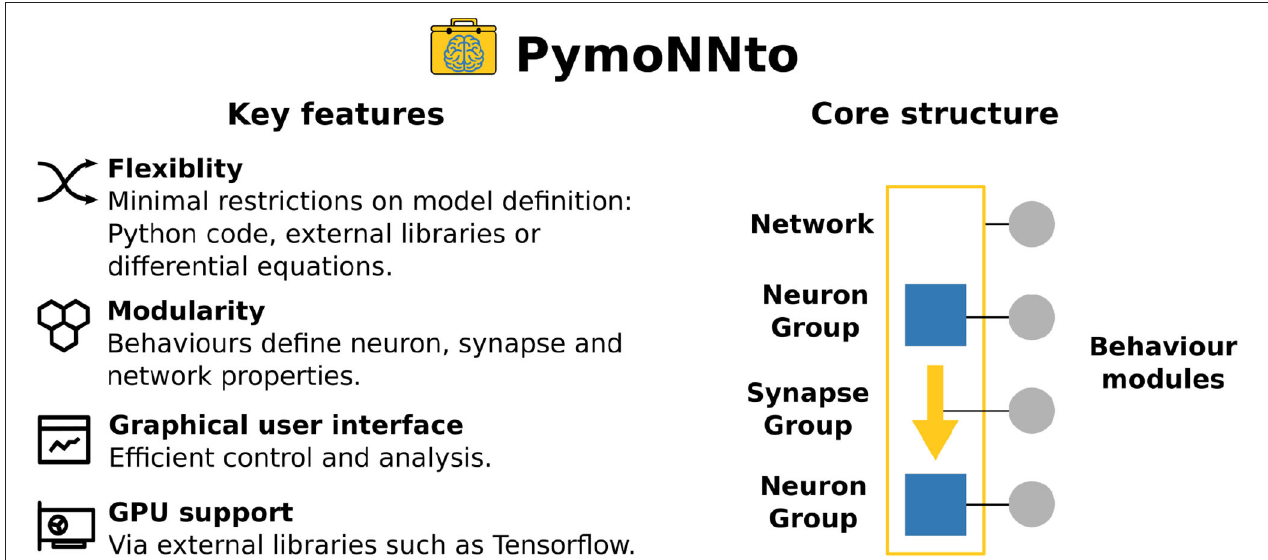
FIGURE 1 | Key features of PymoNNto (left) and its core structure (right) . The core structure consists of a Network class, NeuronGroups , SynapseGroups , and Behaviour modules. One Network can have many NeuronGroups and SynapseGroups . One or more Behaviour modules with custom code are attached to all three